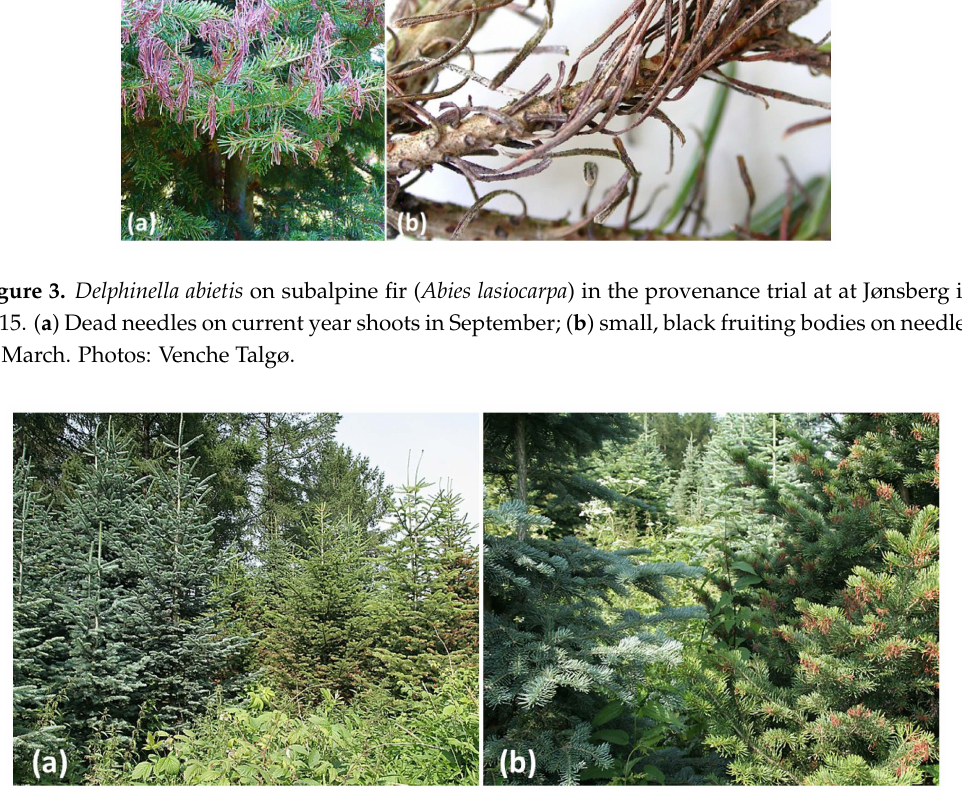
Figure 4. The provenance trial of subalpine fir ( Abies lasiocarpa ) at Jønsberg. ( a ) Blue varieties were generally healthier looking than green varieties; ( b ) typical symptoms of Delphinella abietis on the tree with the green foliage to the right. Photos: Odd Ragnar